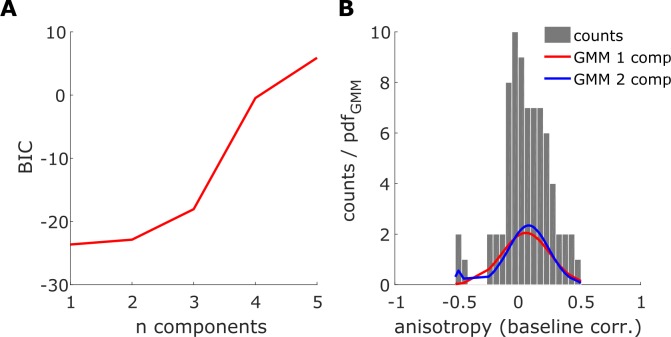
Gaussian Mixture Models on individual anisotropy effects.(A) Bayesian Information Criterion (BIC) for Gaussian Mixture Model (GMM) of n components based on single subject anisotropy values (baseline corrected, that is (wspecific_gen-wunspecific_gen) – (wspecific_base-wunspecific_base)). (B) Histogram of single subject anisotropy values (same as in A). Lines represent probability density functions of the resulting Gaussian distributions of the GMM on n = 1 (red, ‘GMM1’) and n = 2 (blue, ‘GMM2’) components, which are shown in detail as these models resulted in the lowest BIC (BICGMM1 = −23.7, BICGMM2 = −22.9). As visible, GMM1 resulted in one component centered on μ = 0.07, while GMM2 resulted in two Gaussians centered on μ1 = −0.48 = and μ2 = 0.09 with mixing proportions mp1 = 0.04 and mp2 = 0.96.